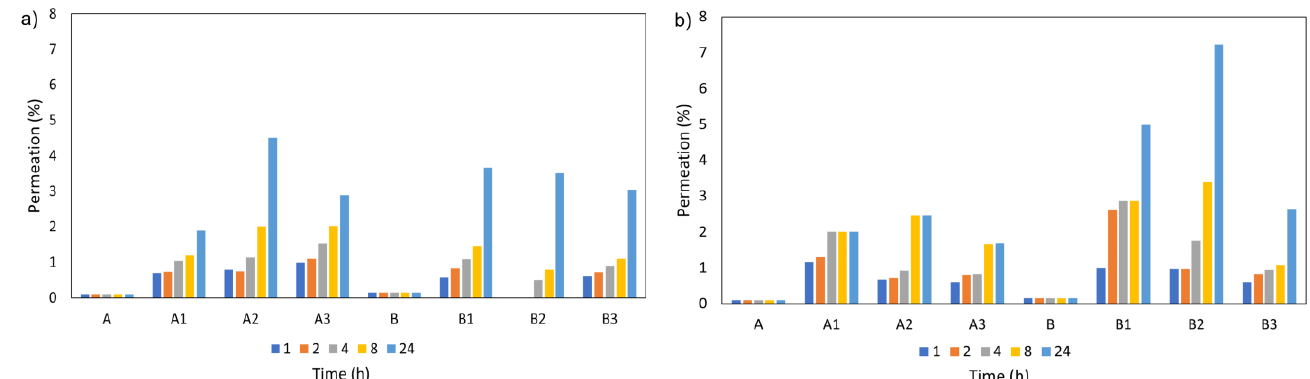
Figure 8. Transdermal permeation values (%) of the extracts through the cellulose acetate membrane and pig skin after 24 h when included into the cosmetic formulations under study: ( a ) Cellulose membrane (formulation A — control andwith the three incorporated extracts (A1, A2, and A3) and formulation B — control and with the three extracts incorporated (B1, B2, and B3)) and ( b ) pig skin (formulation A — control and with the three incorporated extracts (A1, A2, and A3) and formulation B — control and with the three extracts incorporated (B1, B2, and B3)).